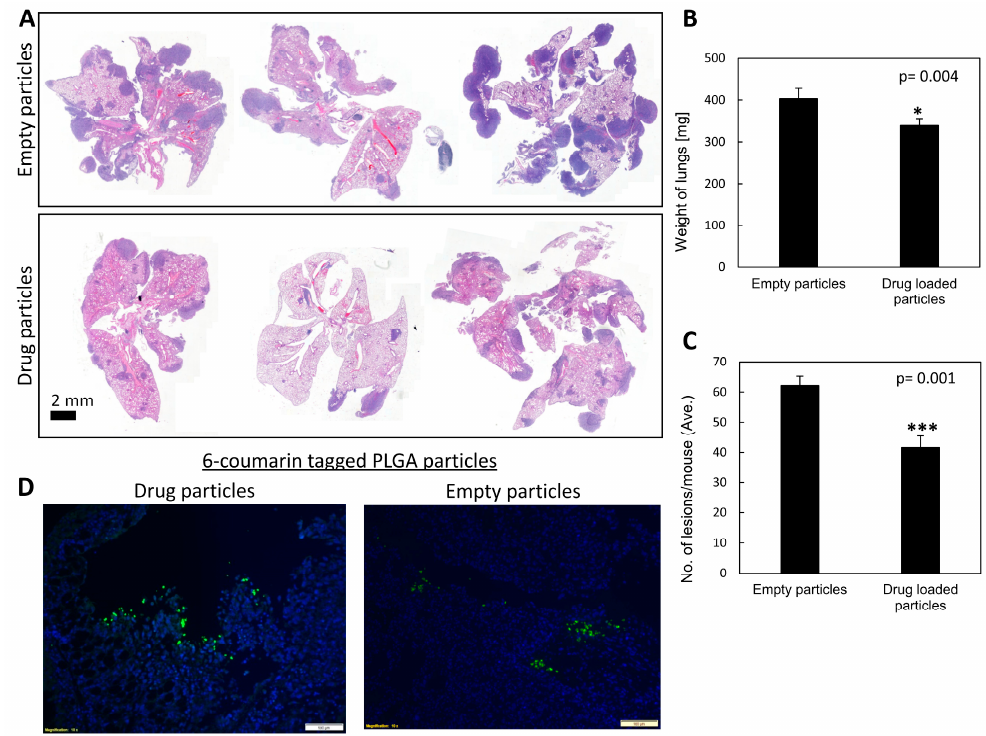
Figure 5. The effect of carbenoxolone loaded particles resulting from intranasal administration (1 mg / mouse, single administration). C57BL / 6J mice were pre-treated intranasally with 6-coumarin drug-loaded particles, or with empty particles as control. On the 5th day, all mice were injected intravenously with Lewis lung carcinoma (LLC) cells (5 × 10 6 ). The endpoint was 20 days after treatment initiation due to death of mice in the control groups, after which lungs of all mice were resected. ( A ) Representative hematoxylin and eosin-stained histological sections of lungs removed from untreated (empty particles- top) or treated groups (10 × ). ( B ) The weight of lungs of untreated mice compared with that of mice treated with carbenoxolone loaded particles, p = 0.004. ( C ) The number of lesions found in the lungs of untreated mice compared with the number found in the lungs of mice treated with carbenoxolone loaded particles, p = 0.0057. ( D ) Representative pictures showing that 6-coumarin tagged particles target the lungs when administered intranasally, with and without drug encapsulation. n = 9–10. * p ≤ 0.05, *** p ≤